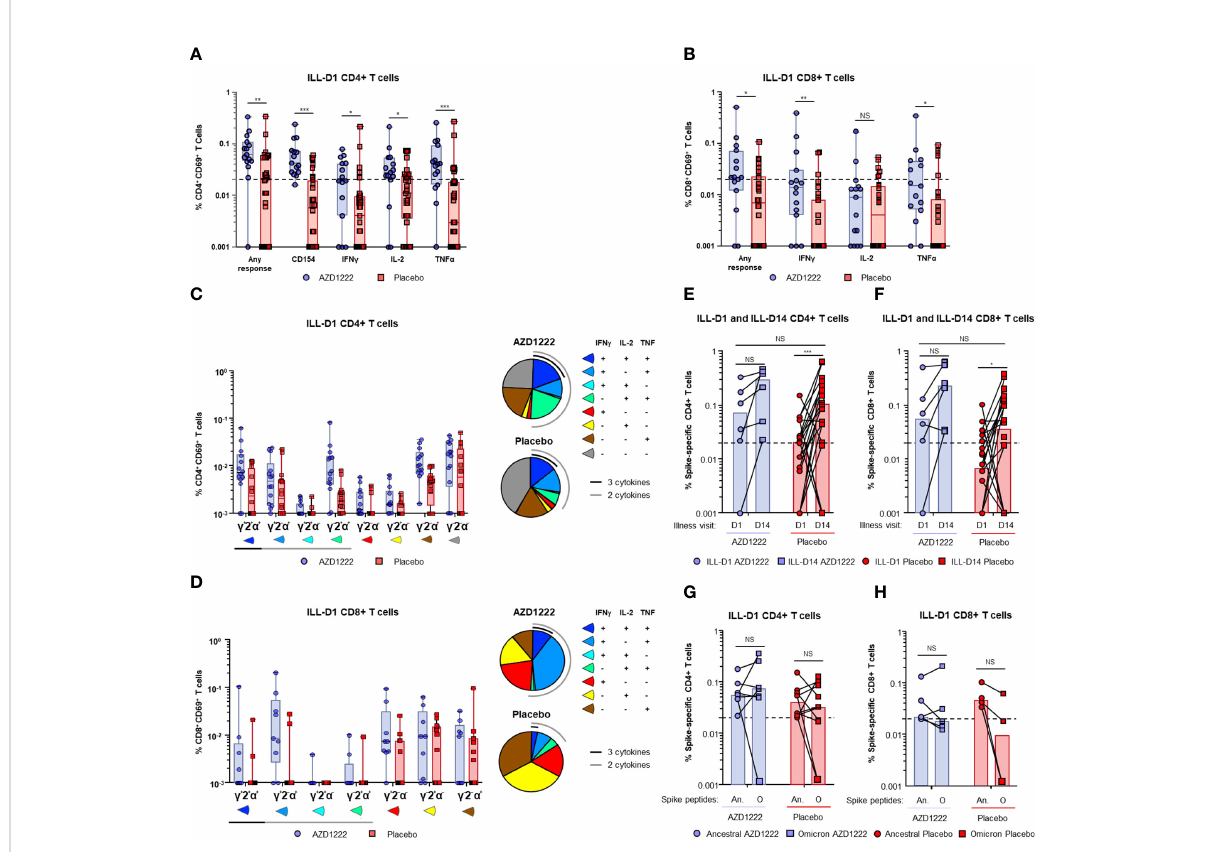
FIGURE 6 AZD1222 vaccinees possess an enriched SARS-CoV-2 spike-speci fi c T-cell response upon symptomatic SARS-CoV-2 infection compared with placebo recipients. T-cell responses from vaccinees and placebo recipients were assessed following stimulation of PBMCs with SARS-CoV-2 spike peptide pools. Frequencies of SARS-CoV-2 spike protein-speci fi c CD4+ T cells (A) expressing CD154, interferon gamma (IFN g ), IL-2, and tumor necrosis factor alpha (TNF a ), or any combination of all four (Any Response), and CD8+ T cells (B) expressing IFN g , IL-2, and TNF a , or any combination of all three (Any Response) are shown. Illness visit day 1 cytokine pro fi les and frequencies of (C) CD4+ and (D) CD8+ T cell populations upon breakthrough infection in vaccinees and placebo recipients. Spike-speci fi c CD4+ (E) and CD8+ (F) T-cell frequencies (Any Response) from participants at ILL-D1 and ILL-D14 are shown. Bars indicate median values within each group. Frequencies of spike-speci fi c CD4+ (G) and CD8+ (H) T-cells (Any Response) against ancestral SARS-COV-2 and Omicron BA.1 variant spike proteins from vaccinee